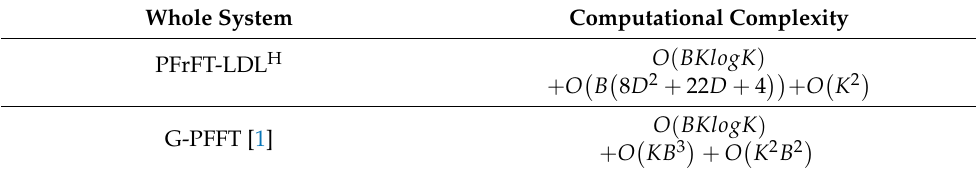
Table 1. Complexity analysis of whole system.